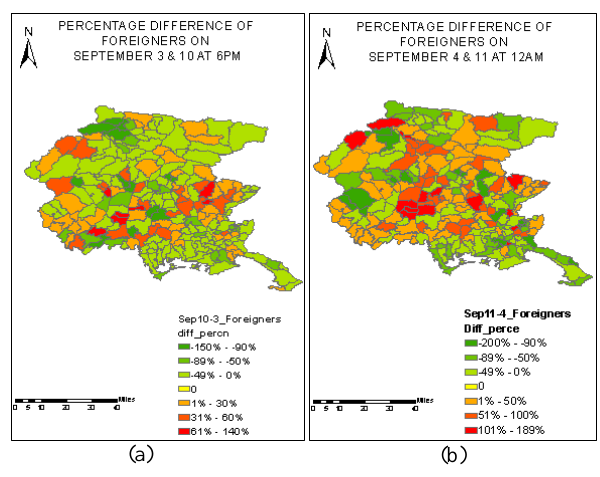
Figure 3.2.1-2 (a) Presence of Foreigners on Sep 3 - 10 @ The fig 3.2.1-2 a, b shown is percentage difference of